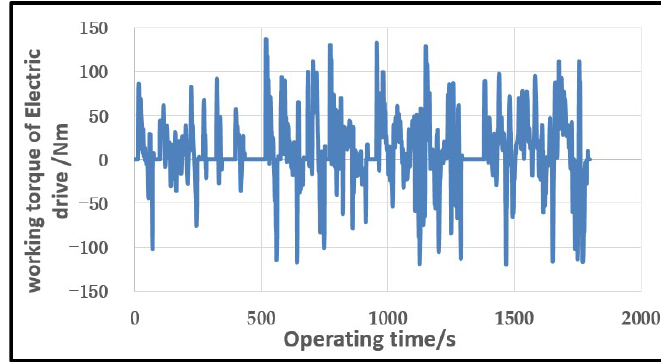
Figure 3. Motor torque versus time.